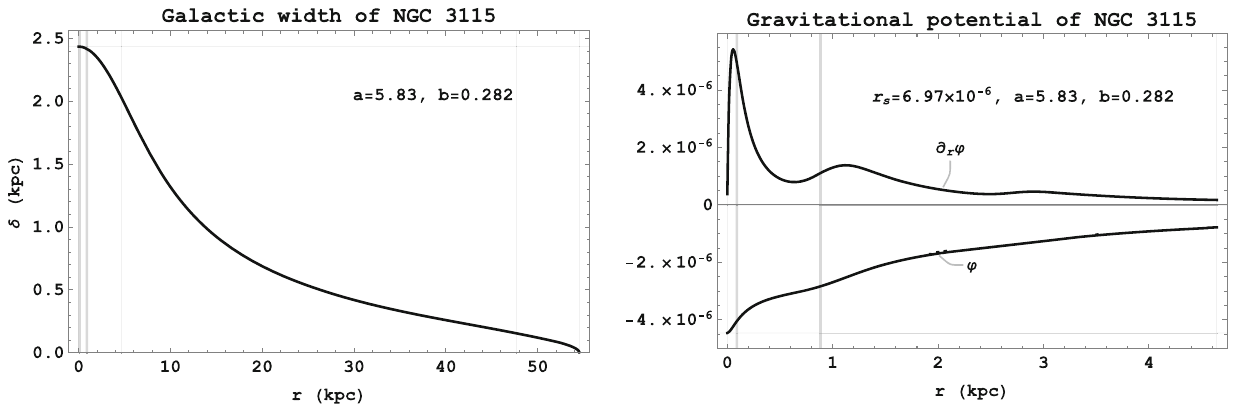
Fig. 11 The left-hand side graphic shows the calculated shape of NGC 3115, and the right-hand side the normalized gravitational potential and its radial derivative along the equatorial plane. The vertical lines in both